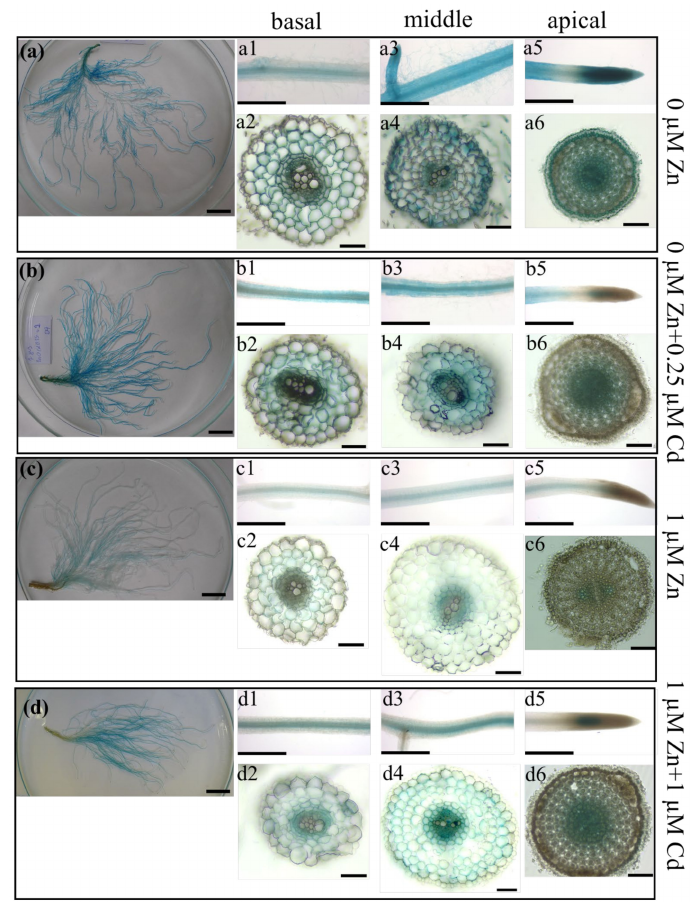
Figure 5. GUS staining pattern of transgenic plants expressing NtZIP4B prom :: GUS . GUS expres- sion in five-week old transgenic plants expressing NtZIP4B prom :: GUS grown in the quarter-strength Knop’s medium for 3.5 weeks and subsequently exposed for 17 days to the control medium supple- mented with pairwise combinations of Zn (0; 1 µ M) and Cd (0; 0.25; 1 µ M) concentrations. Whole roots ( a – d ). Basal root parts ( a1 , b1 , c1 , d1 ) and the cross sections ( a2 , b2 , c2 , d2 ). Middle root parts ( a3 , b3 , c3 , d3 ) and the cross sections ( a4 , b4 , c4 , d4 ). Apical root parts ( a5 , b5 , c5 , d5 ) and the cross sec- tions ( a6 , b6 , c6 , d6 ). Magnification bars: 2 cm for ( a – d ), 1 mm for ( a1 , a3 , a5 , b1 , b3 , b5 , c1 , c3 , c5 , d1 , d3 , d5 ); 0.1 mm for ( a2 , a4 , a6 , b2 , b4 , b6 , c2 , c4 , c6 , d2 , d4 , d6